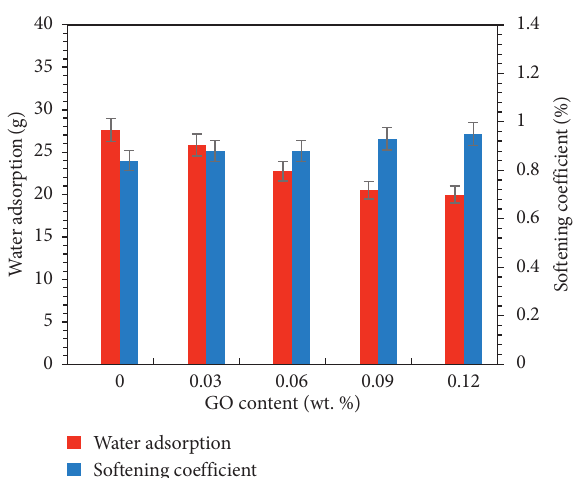
Figure 10: Water adsorption and softening coefficient changing with GO